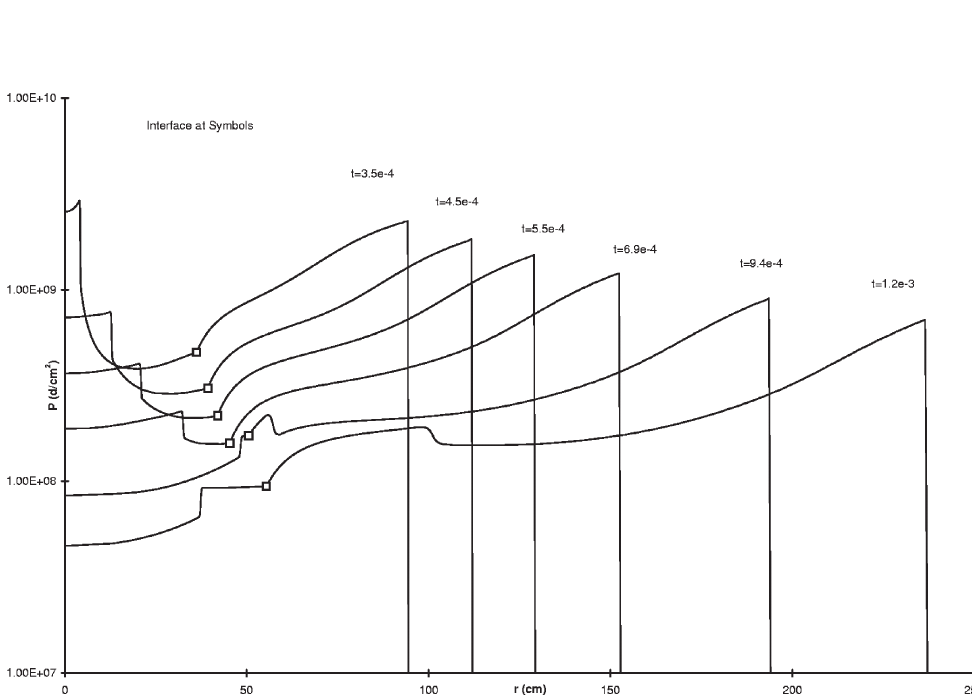
Fig. 3. Non-Uniform Euler Model shock interaction